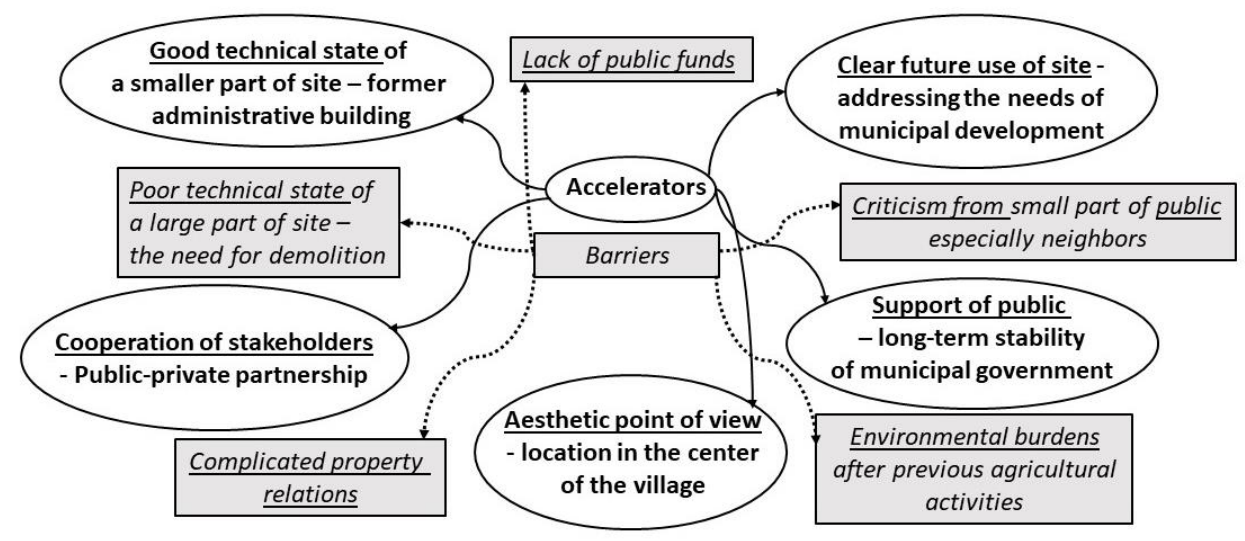
Figure 8. The most important accelerators and barriers governing the successful regeneration of post-agricultural brownfield in Vranovice. Source: Authors ’ own processing.